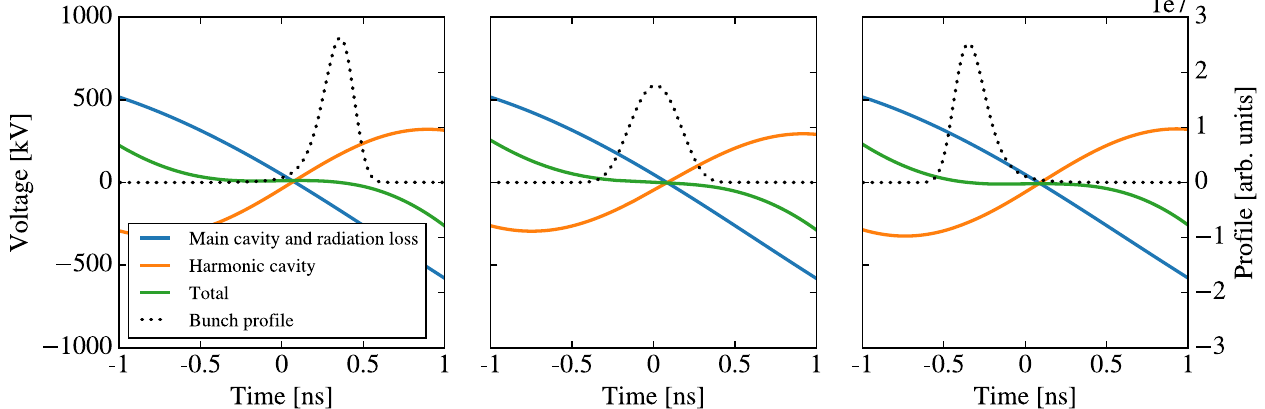
FIG. 3. Example of voltages and bunch profiles for bunch 1, 77, and 156 in the bunch train for a fill pattern with a 210 ns gap in the MAX IV 3 GeV storage